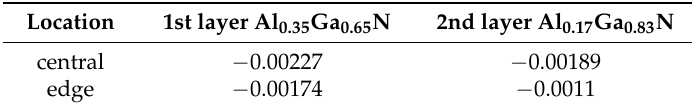
Table 1. Calculated in-plane strain components of the two strain-compensation Al x Ga 1 − x N layers for both the wafer central and edge regions measured along the [1124]